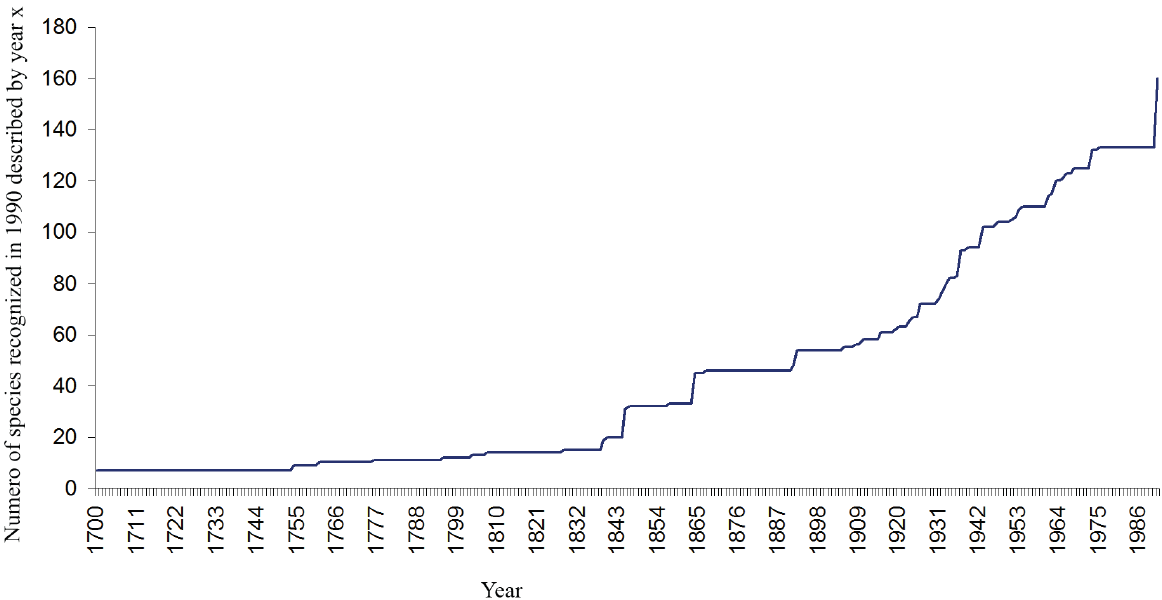
Figure 3 - Species discovery curve for Amazonian